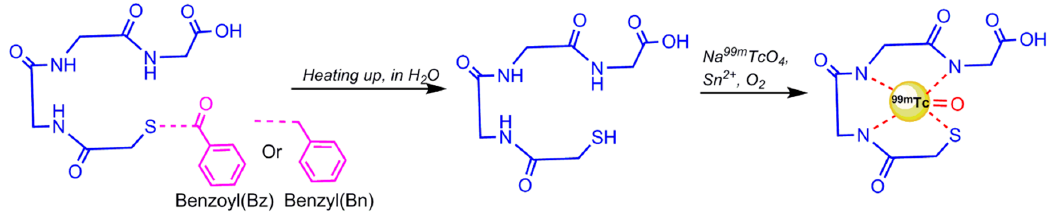
Figure 3. 99m Tc radiolabeling of S-benzoyl Mercaptoacetyltriglycine (MAG 3 ) chelator.